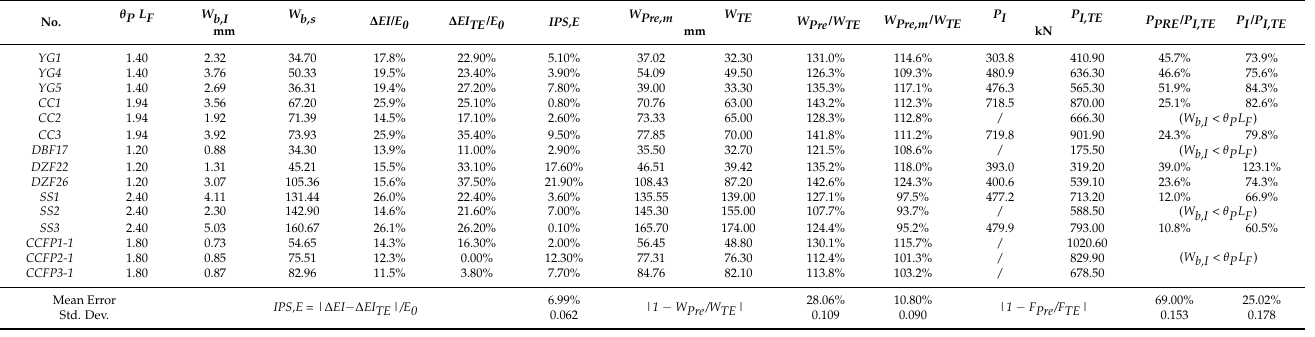
Figure 9. Results of the qualitative analysis.